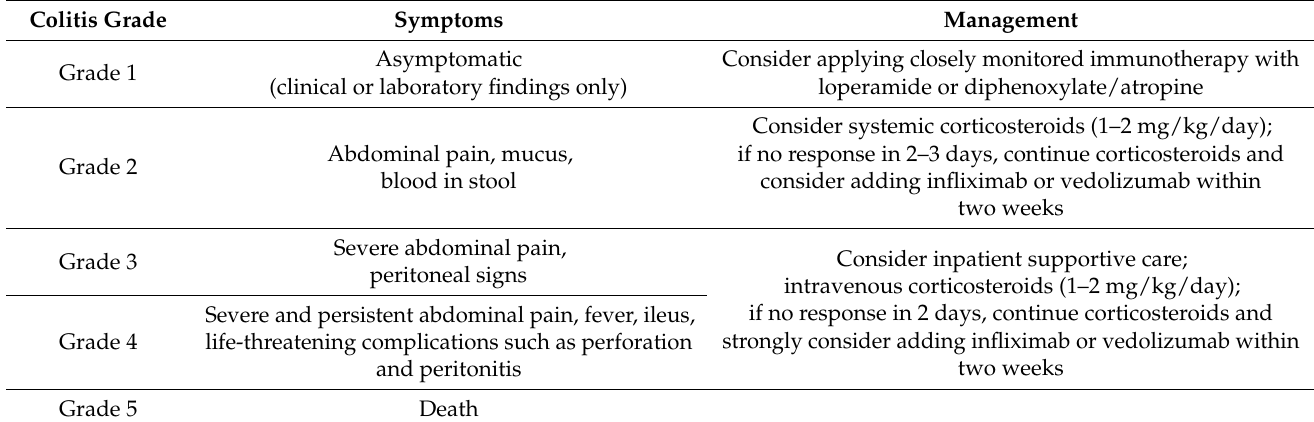
Table 1. Grading the severity of irAE colitis based on Common Terminology Criteria for Adverse